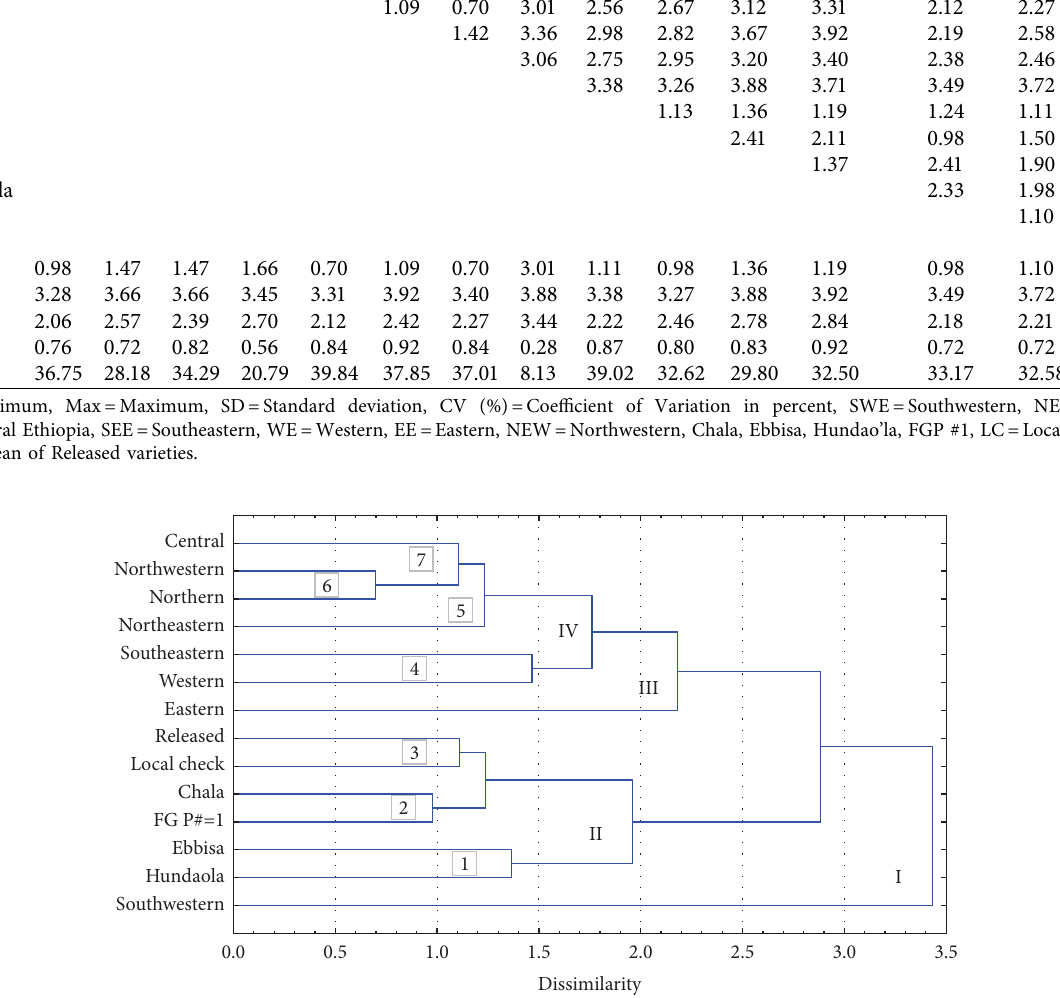
Figure 1: Dendrogram generated based on the UPGMA clustering method depicting relationships among accessions of eight geographic regions and fve checks based on groups mean values for 11 agromorphological traits.